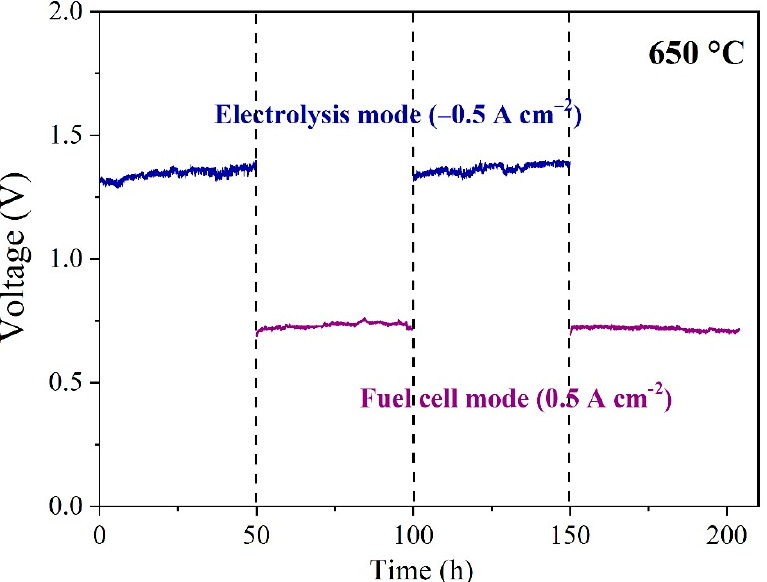
Figure 9. The stability of Cell 2 operated between the electrolysis (@ − 0.5 A cm − 2 ) and fuel cell modes (@ 0.5 A cm − 2 ) at 650 °C.